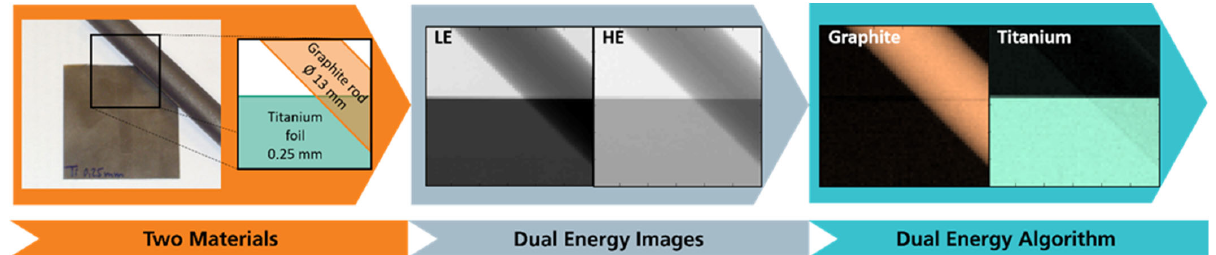
Figure 3. Schematic of the data-processing steps of the basis material decomposition, for simplification with two pure materials: a graphite rod partly overlapping a titanium foil. LE and HE indicate the two images (low and high energy) obtained by the dual-energy X-ray detector which do not allow a differentiation of the two materials. The analysis yields two basis material images showing only graphite or titanium, respectively (created from data published previously in [29]).